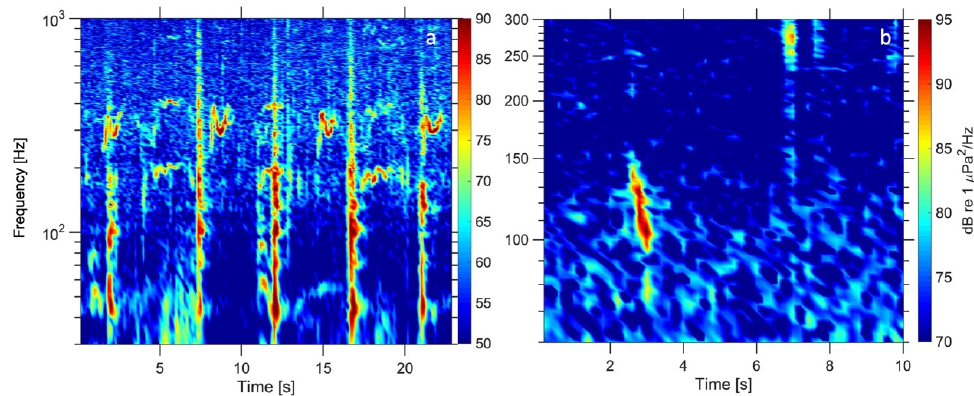
Figure 4. Spectrograms of humpback calls (300 Hz) with non-vocal sounds from surface behaviours (40–100 Hz; a ) and a Bryde’s whale vocalisation ( b ). Note that the frequency axis and colour bars have different ranges.